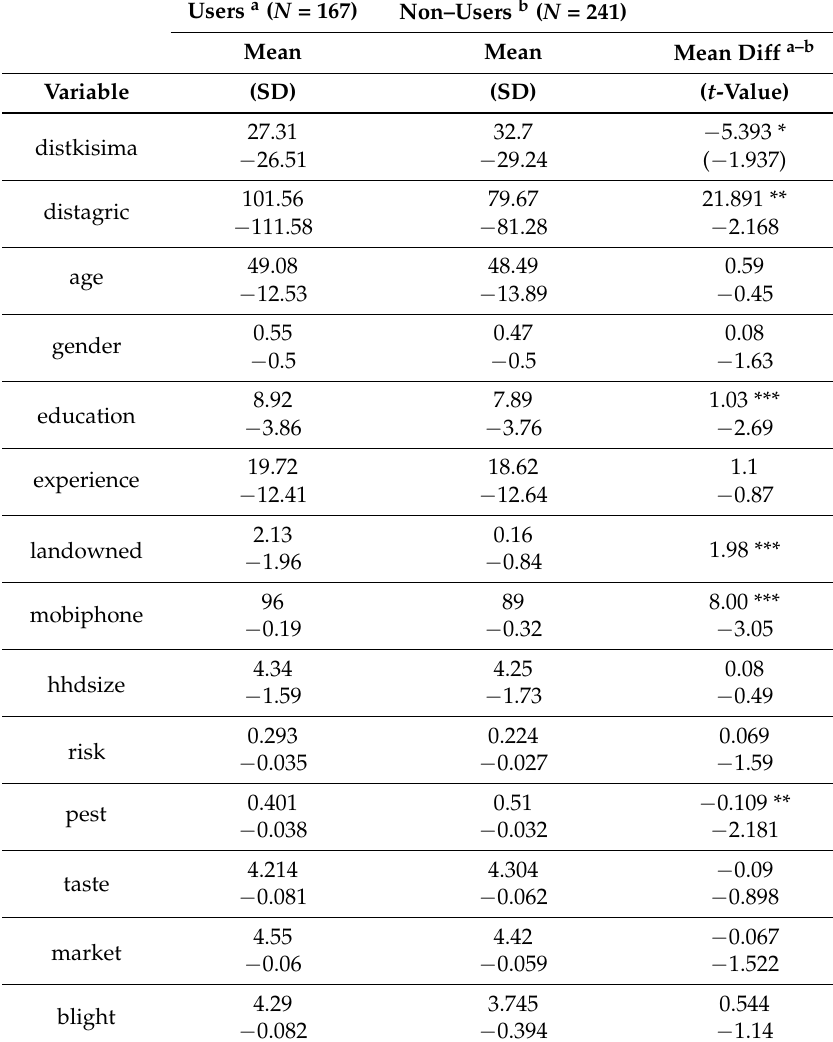
Table 2. Socioeconomic characteristics of the study